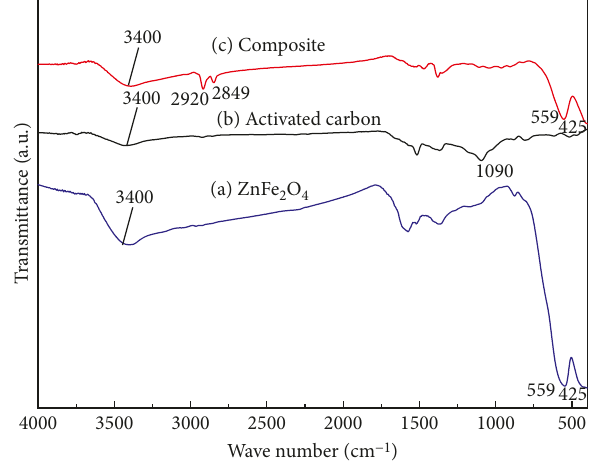
Figure 8: FT-IR spectra of activated carbon and ZnFe